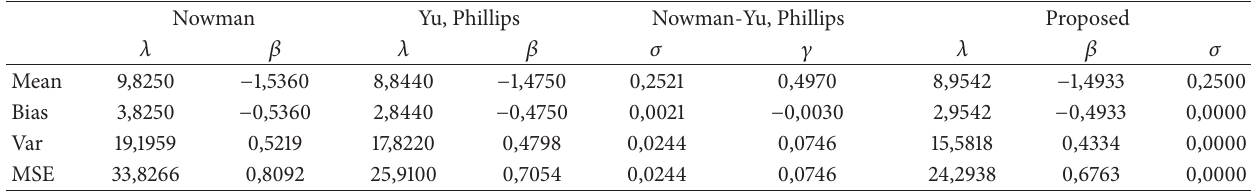
Table 5: Comparison of daily data series with Nowman, Yu-Phillips, and proposed methods.